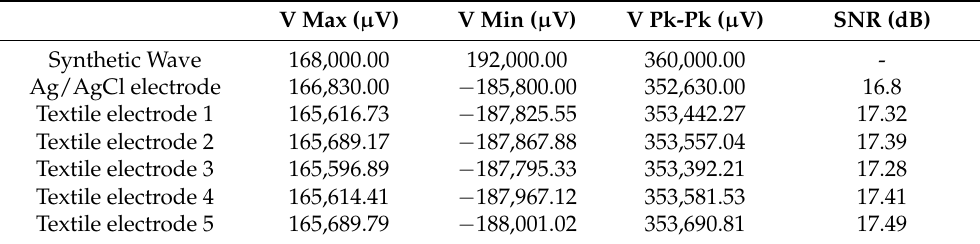
Table 2. Injected synthetic wave, acquired signal, and SNR of the textile-based